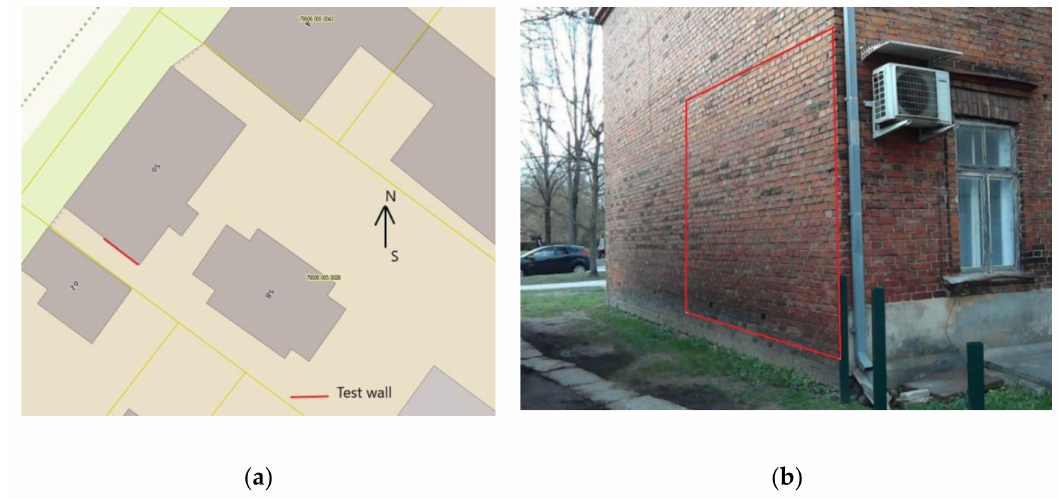
Figure 2. The test building: ( a ) building location and ( b ) the original wall from outside (red